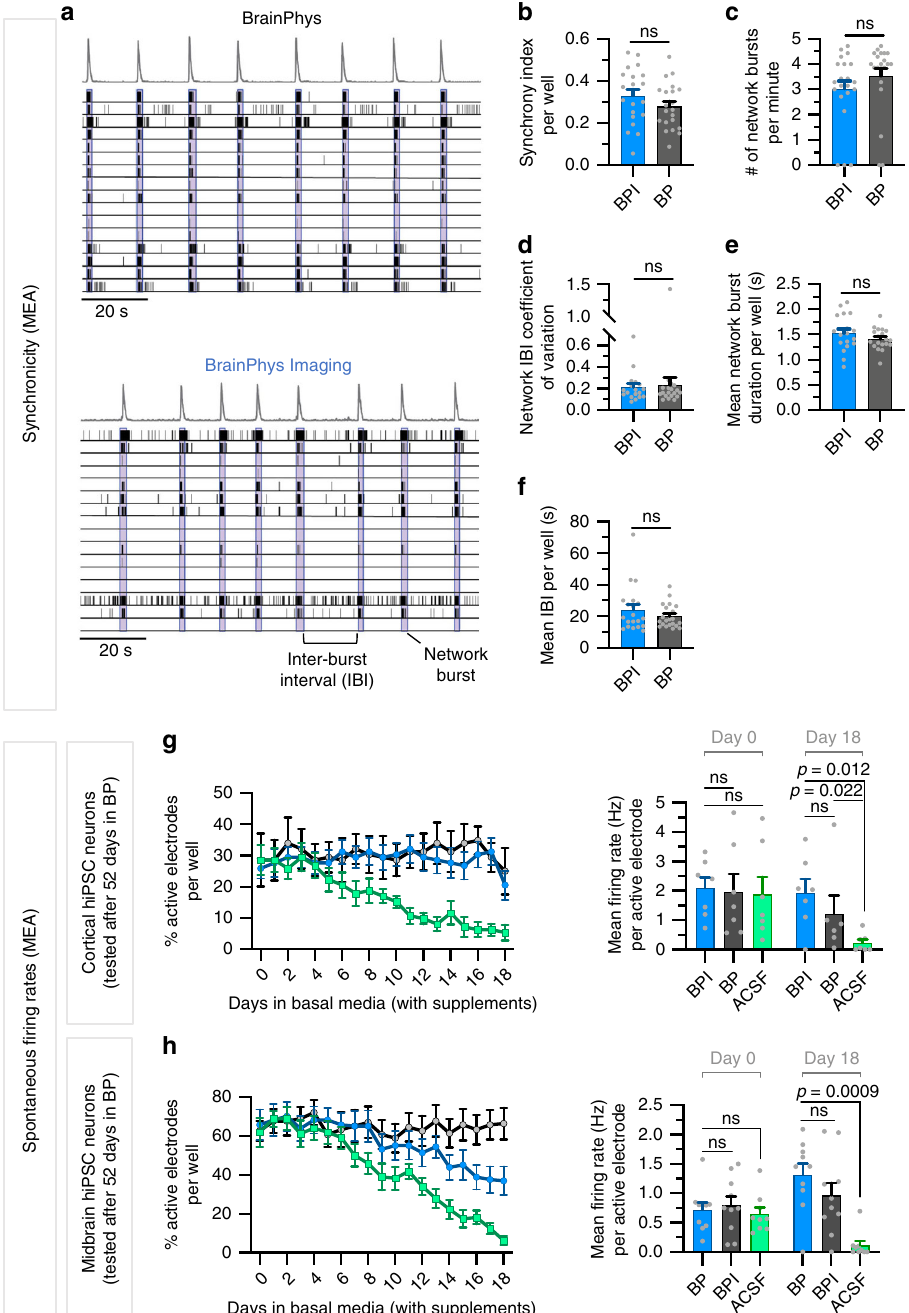
Fig. 5 BrainPhys Imaging supports neural network synchrony and long-term electrophysiological activity of human neuronal populations in vitro. a – f Midbrain human iPSC-derived neurons were matured for 100 days in BP before switching to standard BrainPhys (BP) or BrainPhys Imaging (BPI) for 2 h. The same midbrain supplements were added to all basal media. Network activity was compared on 48-well multielectrode array (MEA) plates over 7-min time intervals. Each value represents the average recorded across 16 electrodes per well, with a total of 18 – 21 wells per condition. a Example 2-min raster plots of neuronal network activity in BPI or BP show similar network activity (blue boxes) and spike histograms (gray, top). b – f Quanti fi cation of MEA network activity showed no signi fi cant differences between BPI and BP media for: b synchrony index ( n = 21 wells per condition), c number of network events per minute ( n = 21 wells per condition), d network interburst interval (IBI) coef fi cient of variation ( n = 18 wells per condition), e mean network burst duration (BPI, n = 18 wells; BP, n = 19 wells) and f mean IBI duration (BPI, n = 20 wells; BP, n = 21 wells). g , h Cortical and midbrain human iPSC-derived neurons were matured for 52 days in standard BP. Spontaneous fi ring rates were then compared using MEA recordings over 18 days in BP (black), BPI (blue) and arti fi cial cerebrospinal fl uid (ACSF; green). The same cortical or midbrain supplements were added to all three basal media. Spontaneous MEA activity was recorded for 10 min every 24 h across 16 electrodes per well for 29 wells of midbrain (9 – 10 wells per condition) and 20 wells of cortical (6 – 7 wells per condition) cultures. For both midbrain and cortical cultures, the spontaneous fi ring activity was similar in BP, BPI, and ACSF at fi rst but progressively decreased in ACSF after several days. Data in b – h are presented as mean ± SEM. Signi fi cance determined via two-tailed nonparametric unpaired (Mann – Whitney) tests. Nonsigni fi cant P -values >0.05 are annotated with